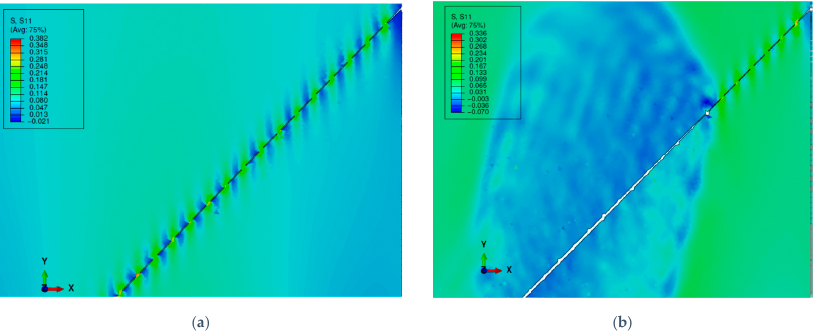
Figure 11 . ( a ) Fiber direction stress field in MD for cuts at 45°; ( b ) rupture starting in the lower edge Figure 11. ( a ) Fiber direction stress field in MD for cuts at 45 ◦ ; ( b ) rupture starting in the lower edge running to the center . running to the